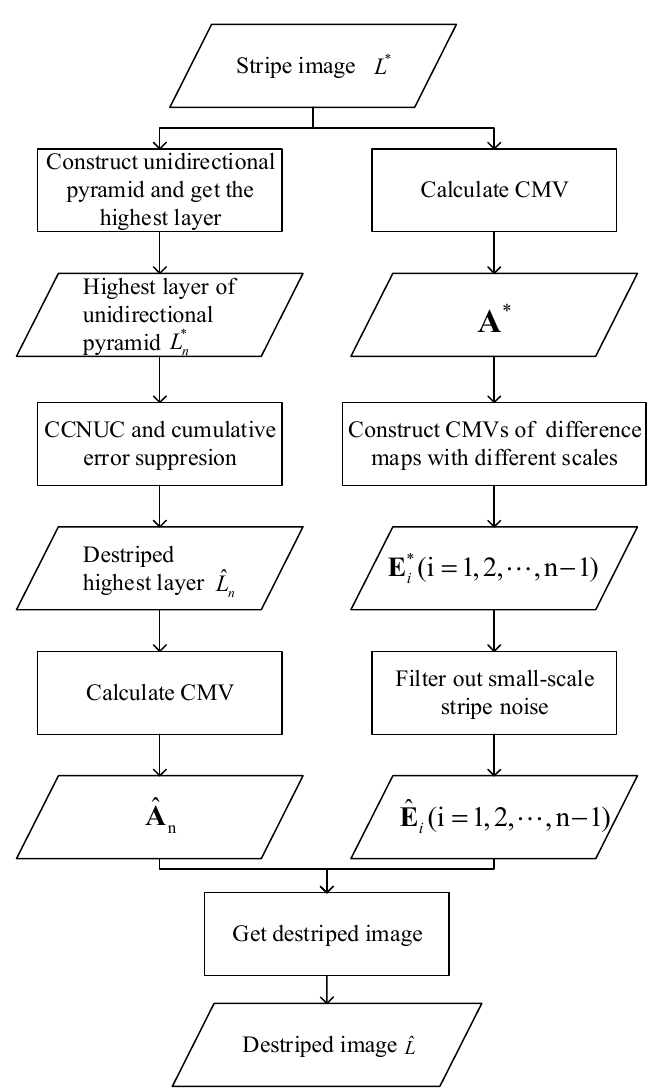
Figure 2. Overall flow chart of DUMD (destriping method via unidirectional multiscale decomposition). CCNUC, column-by-column nonuniformity correction.